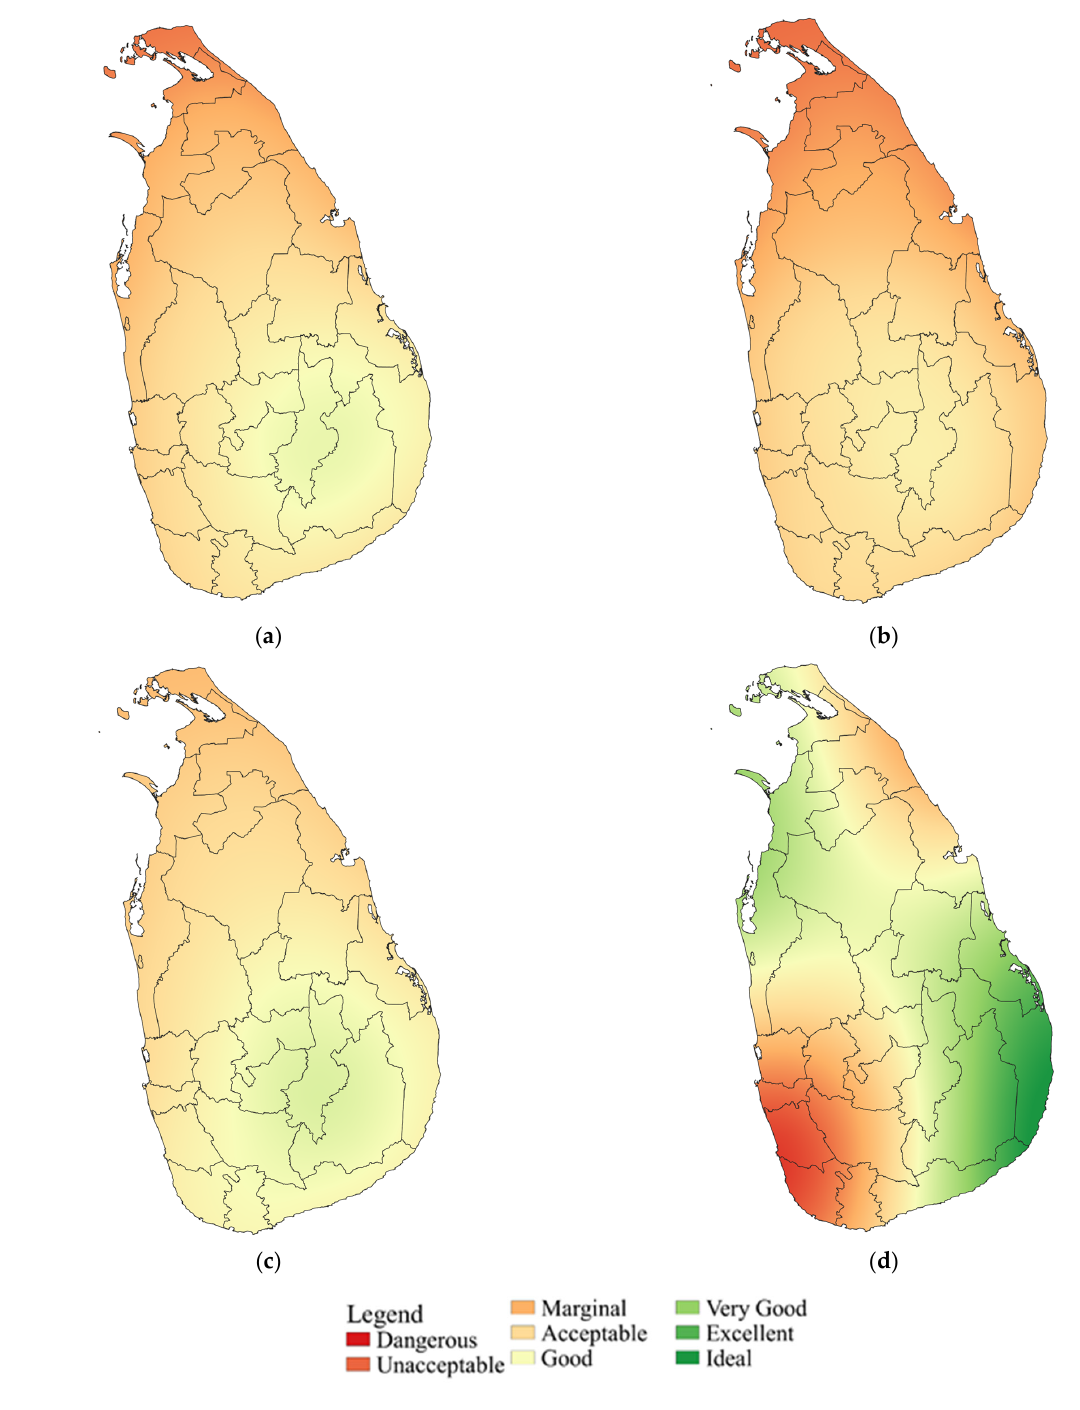
Figure 5. Spatial distribution of TCI scores for 2010–2018: ( a ) For 1st Inter monsoon; ( b ) For Southwest monsoon; ( c ) For 2nd Inter monsoon; ( d ) For Northeast monsoon.